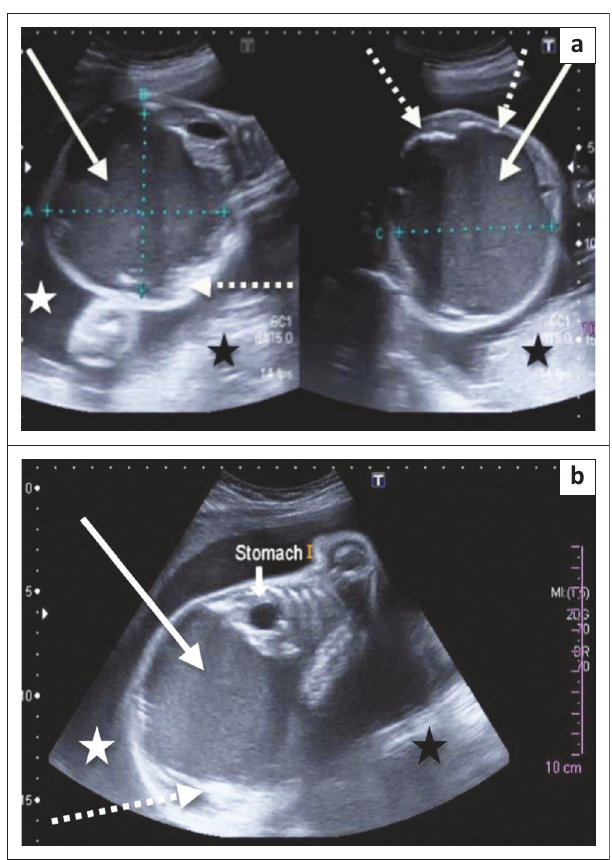
FIGURE 1: Transverse (a) and coronal (b) antenatal ultrasound at 28 weeks revealed a large, cystic intra-abdominal mass with internal echoes (white arrows) and calcified rim (dashed arrows) within the fetus. Note the polyhydramnios (white star) and oedematous placenta (black star).